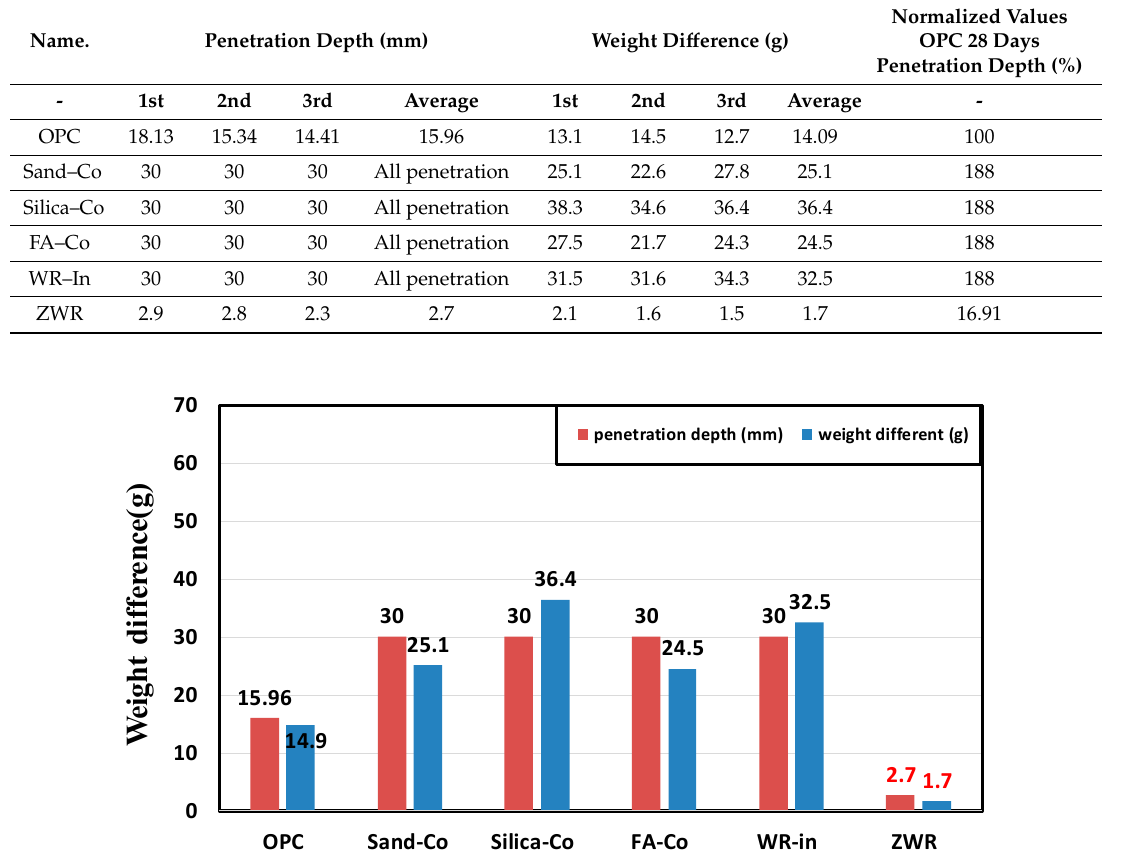
Table 12. Result of water penetration test.